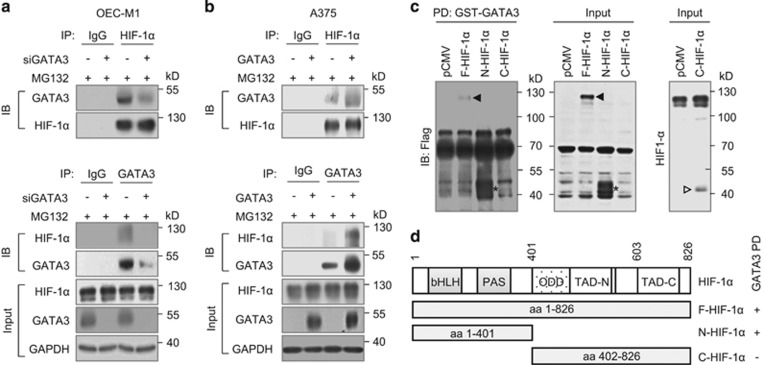
GATA3 physically interacts with HIF-1α. (a, b) Co-immunoprecipitation assays of GATA3 and HIF-1α in OEC-M1 and A375 cells. OEC-M1 cells were transfected with non-targeting siRNA or GATA3 siRNA (siGATA3-2) and A375 cells were transfected with Mock or GATA3 plasmid. Cells were incubated with MG132 (20 μM) and CoCl2 (800 μM) for 6 h. Upper panel, cell lysates were immunoprecipitated with IgG control antibody or anti-HIF-1α antibody and then immunoblotted with anti-GATA3 or anti-HIF-1α antibody. Lower panel, cell lysates were immunoprecipitated with IgG control antibody or anti-GATA3 antibody and then immunoblotted with anti-HIF-1α or anti-GATA3 antibody. HIF-1α, GATA3 and GAPDH in whole cell lysates (input) were shown. (c) GST pull-down assays. 293FT cells were transfected with F-, N- or C-HIF-1α/pCMV-Tag 4A (Flag-tagged) and incubated with CoCl2 (800 μM) for 4 h. Left panel, GST-GATA3 fusion protein pulled down F-HIF-1α and N-HIF-1α, but not C-HIF-1α. On the same membrane, C-HIF-1α could not be detected by the rabbit anti-HIF-1α polyclonal antibody (Cell Signaling Technology), which is known to recognize this region (Ser653, data not shown). The black arrowhead indicates F-HIF-1α. The asterisk indicates N-HIF-1α. The expression of F-HIF-1α and N-HIF-1α was confirmed by western blotting and shown in the middle panel. For unknown reason, C-HIF-1α could not be detected by anti-Flag antibody. We used rabbit anti-HIF-1α polyclonal antibody (Cell Signaling Technology) to confirm C-HIF-1α expression as shown in the right panel (hollow arrowhead). (d) The design of HIF-1α constructs is based on known functional domains and the pull-down assay results were summarized schematically. PAS, Per-ARNT-Sim.